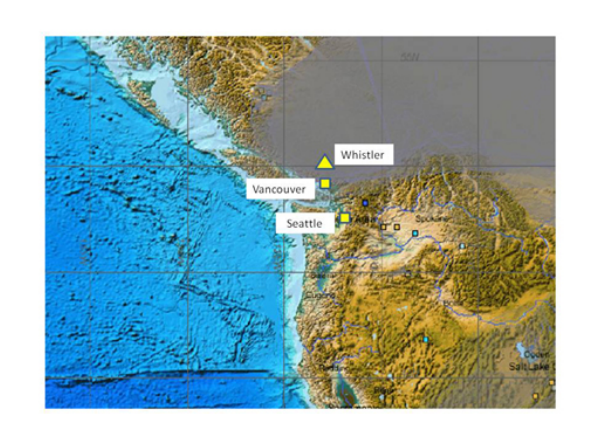
Fig. 4. Satellite smoke detections shown in gray for the period 29-30 August 2009 (courtesy http://map.ngdc.noaa.gov/website/